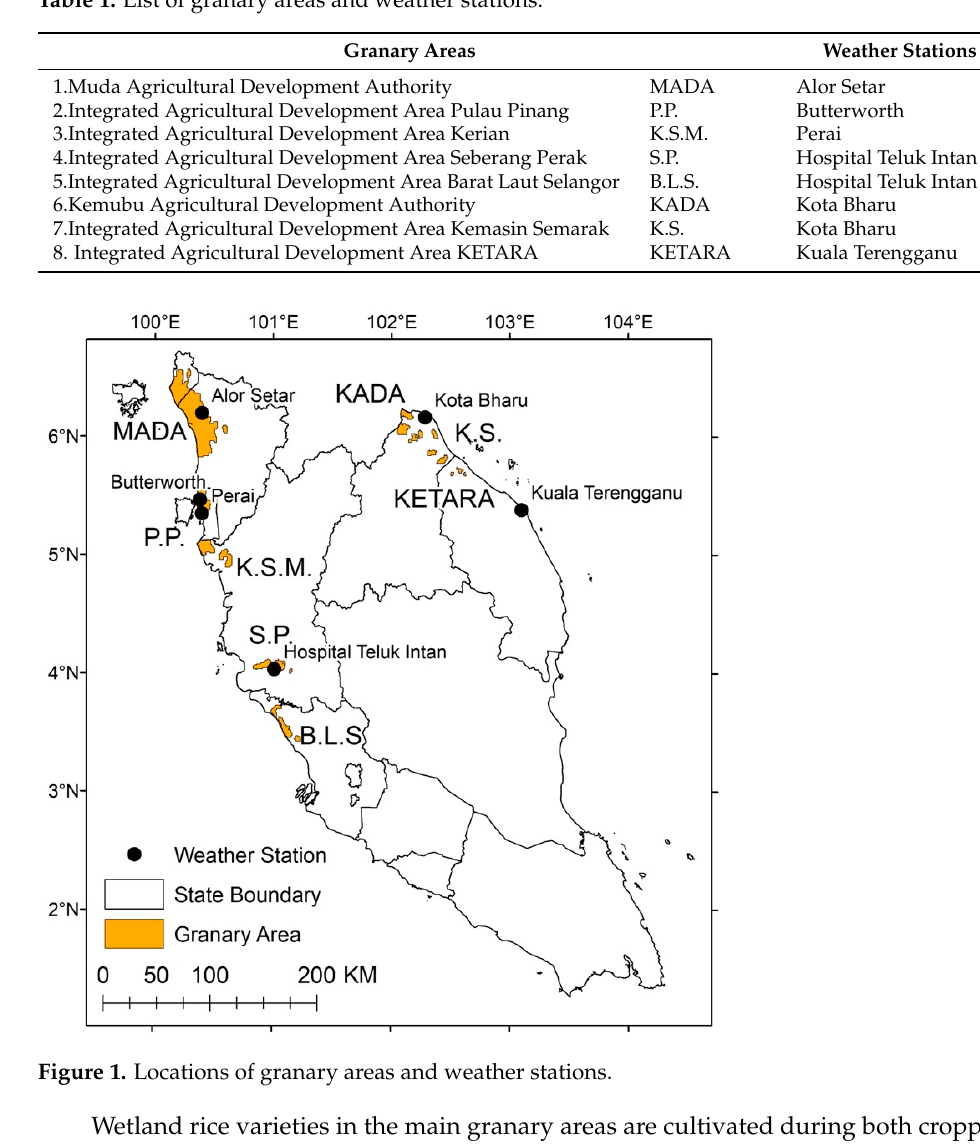
Table 1. List of granary areas and weather stations.